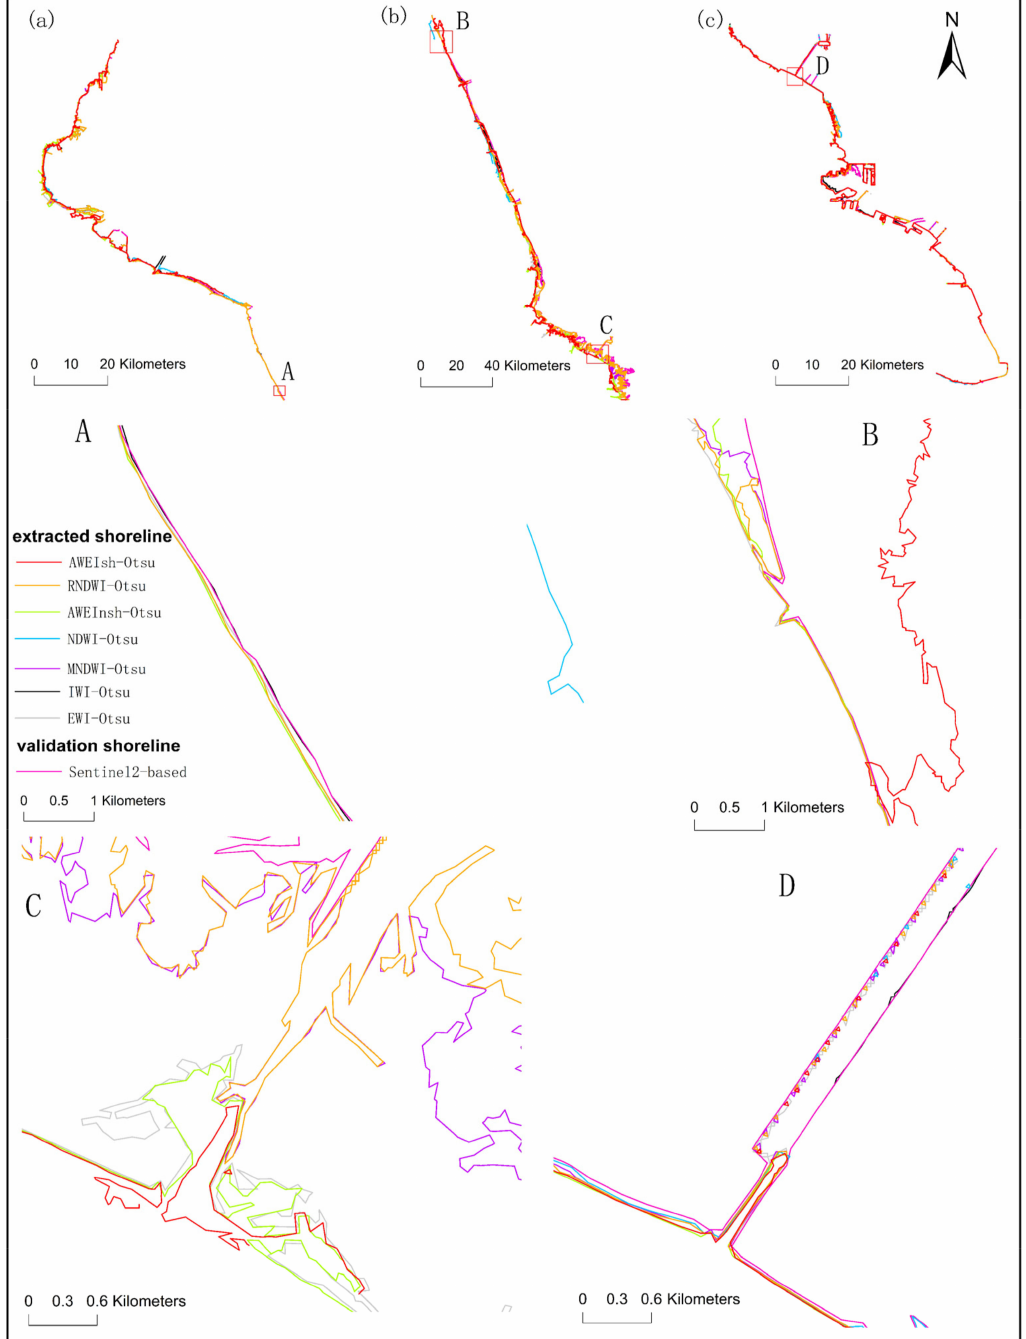
Figure 5. Comparison image of extracted coastline results: ( a – c ) the result maps of northern, central and southern coastlines of Jiangsu extracted using various methods; enlarged maps of local results, where ( A – D ) are the overlapping